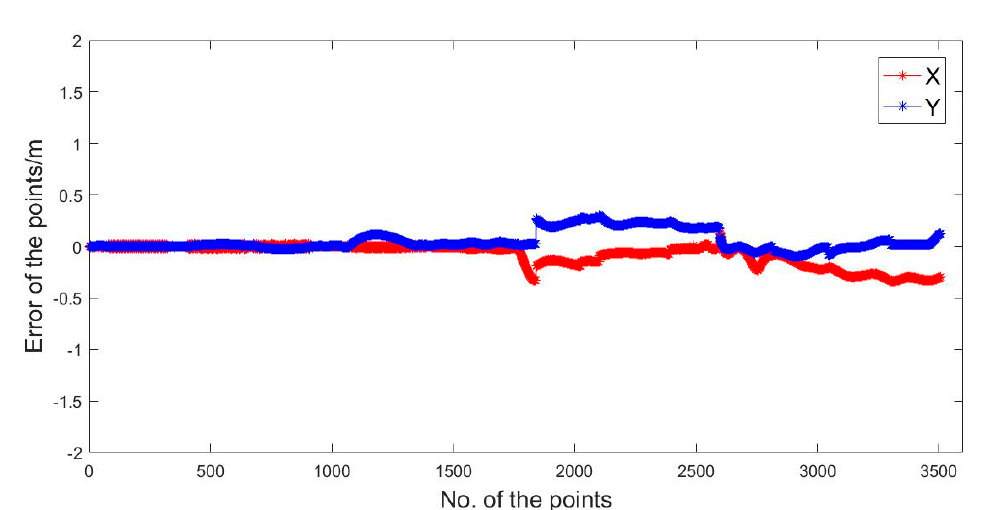
Figure 16. The UWB/Vison combination positioning errors. Table 4. RMSE values of the positioning accuracy of UWB alone and UWB/Vision.